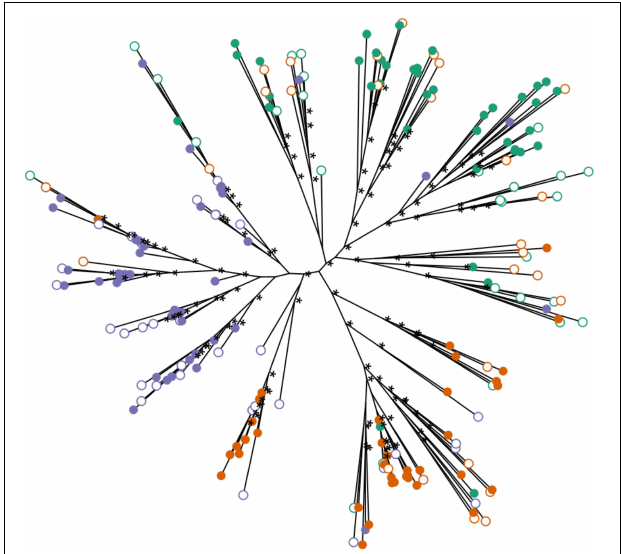
FIGURE 5 | Unrooted phylogenetic tree of S. alterniflora populations by maximum likelihood based on all SNPs filtered for MAF > 10% and no missing data. Each dot represents one stem; populations are indicated by color (Green = Bowens Island, Red = Folly Beach, Blue = Fort Johnson) and habitats are filled (low marsh plants) or open (high marsh plants). Asterisks indicate maximum likelihood support with bootstrap values greater than